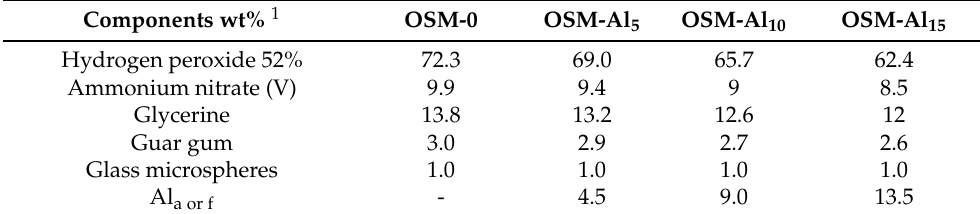
Table 1. Components in based formulation.